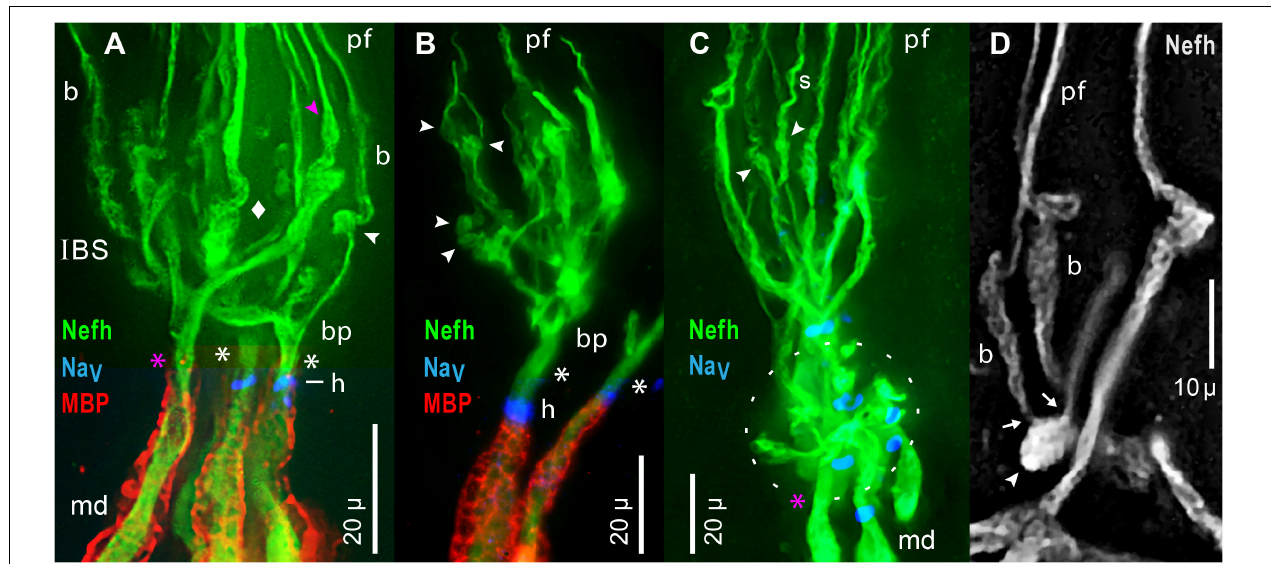
FIGURE 9 | Inline branching structures (IBS), in clusters, were immunolabeled per keys by anti–neurofilament-H (Nefh), or anti–myelin basic protein (MBP), or by a pan Ab to voltage gated Na ion channels (Na V ). (A) IBSs included proximal branch points (bp) and thick irregular twisted processes (diamond). (A–D) IBSs contained numerous globular ovoid swellings (arrowheads) which gave rise to submicron unmyelinated neurites and projection fibers (pf). In-between them could be segments having a braided (b in A,D ) or spiral (s in C ) appearance. Some ovoids tapered distally (pink (cid:74) in A), and directly gave rise to a projection fiber, without an intervening braided structure. (A–C) A single root afferent process ( ), undivided and unmyelinated (MBP–), connected each IBS to the start of a myelinated (MBP+) internode proximally. Some roots (white asterisks) had a Na V + heminode (h), but adjacent roots in similar focal planes lacked Na V immunoreactivity (pink asterisks in A,C). (A,B) Superimposed images of MBP+ and Na V + labeling were cropped to include the relevant internode and heminode regions, but not diffuse MBP+ or Na V + labeling in overlying terminal glia which obscured the Nefh+ processes in IBS clusters. (C) The oval dashed line enclosed an adjacent IBS cluster, viewed end-on, with short lateral dendrites. (D) This partial IBS showed Nefh+ afferent neurite bundles (arrows) erupting from an ovoid structure (arrowhead), leading to braided (b) segments, then to projection fibers (pf) of different calibers. Red fluorescence, 4x resampled; the surface mottling of neuronal processes was also visible in single raw images. (A–D) 40x 0.7 NA